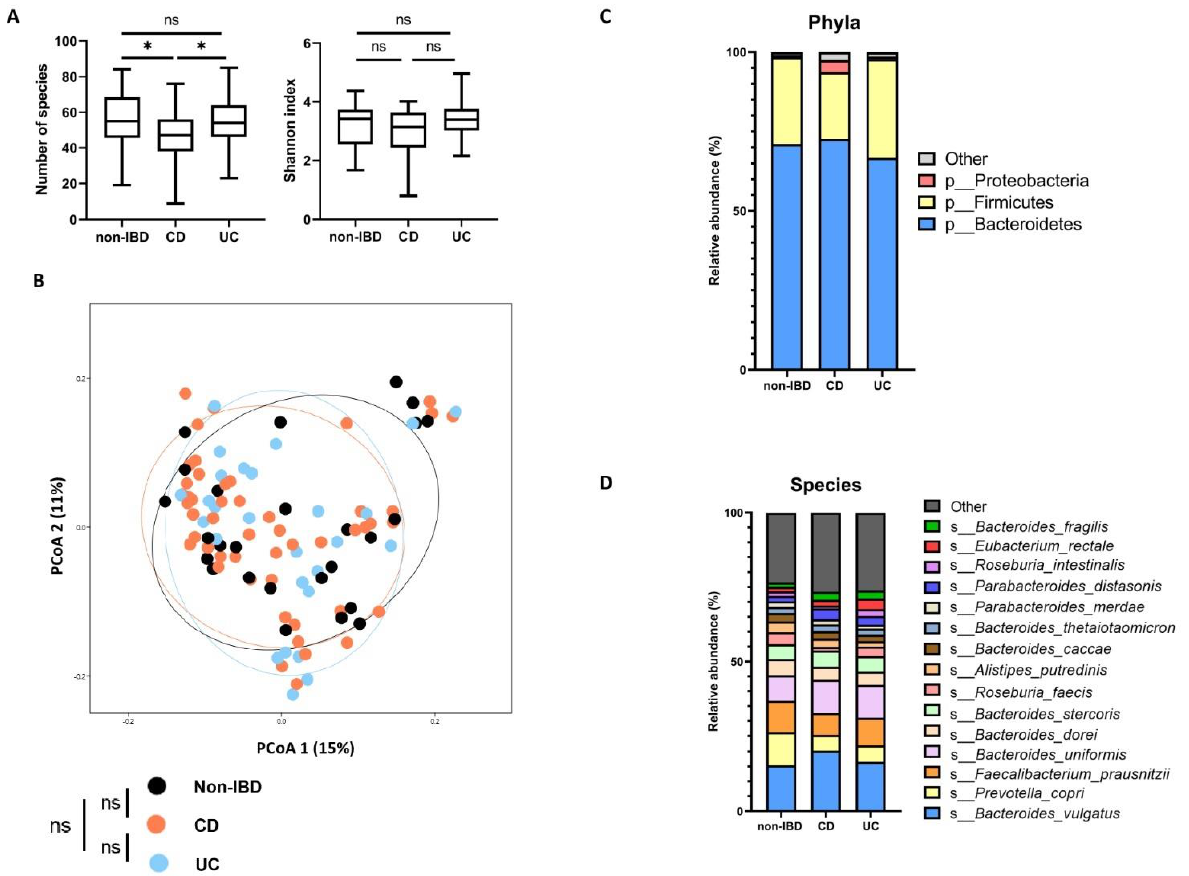
Figure 2. Microbiota composition according to disease phenotype. ( A ) Number of observed species and Shannon index describing alpha diversity of bacterial microbiota (Kruskal – Wallis test with Dunn’s multiple comparison test). ( B ) Principal coordinate analysis of Bray – Curtis distances with each sample coloured according to the disease phenotype. PCoA1 and PCoA2 represent the top two principal coordinates that captured most of the distance. The fraction of distance captured by the coordinate is given as a percentage. Groups were compared using the Permanova method. ( C , D ) Global composition of bacterial microbiota at the phyla and species level. Non-inflammatory bowel disease controls (non-IBD) and patient subgroups are labelled on the x -axis and expressed as the relative abundance in the metagenome for each group. In all panels, ns: non-significant, * p < 0.05, CD: Crohn’s disease , UC: ulcerative colitis.